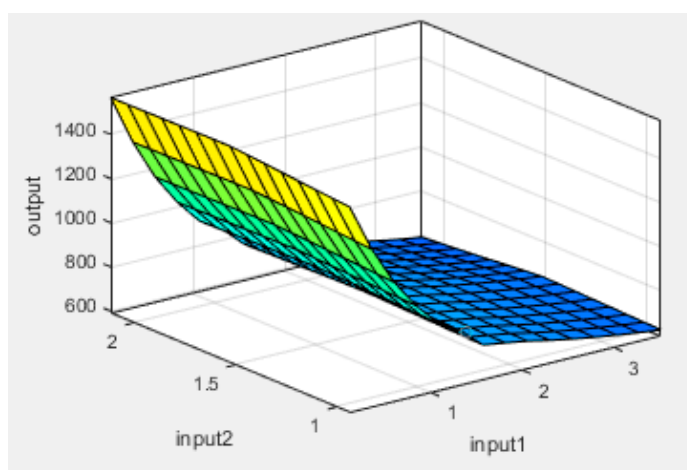
Figure 6. Plot of predicted and measured HRC for training.